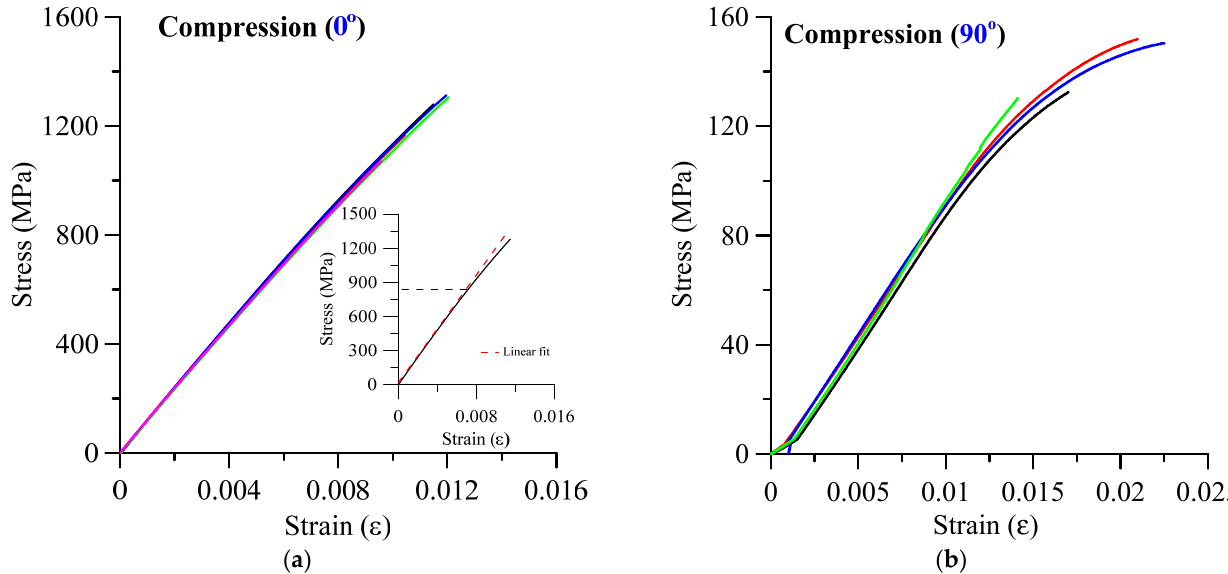
Figure 5. Stress–strain curves in compression mode for different orientations; ( a ) 0°; ( b ) 90°. Table 2. Mechanical properties in compression mode of uniform coupons for the two orientations.